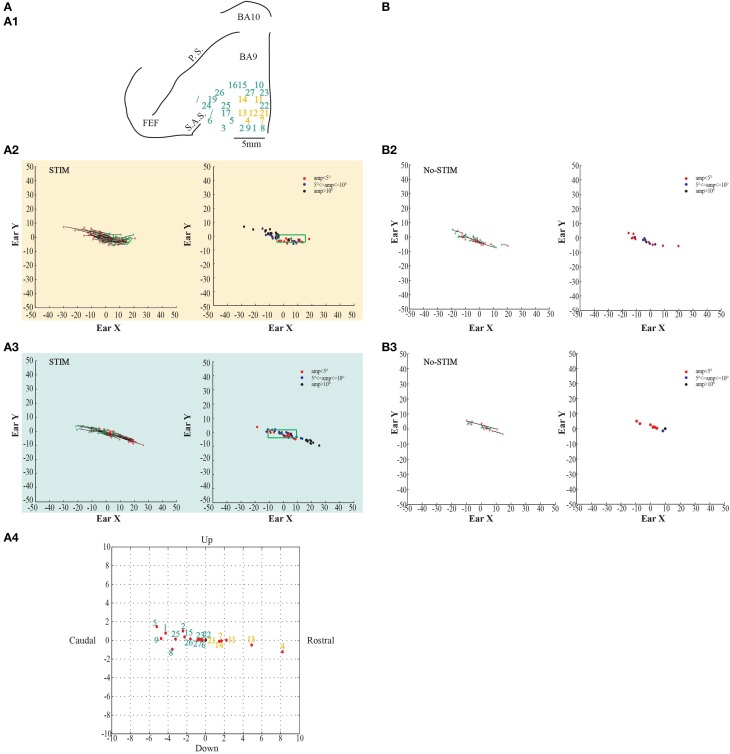
Example of goal-directed ear movements. (A) The figures show data from Monkey S. For further information on the figures the reader should refer to the legend of Figure 2.